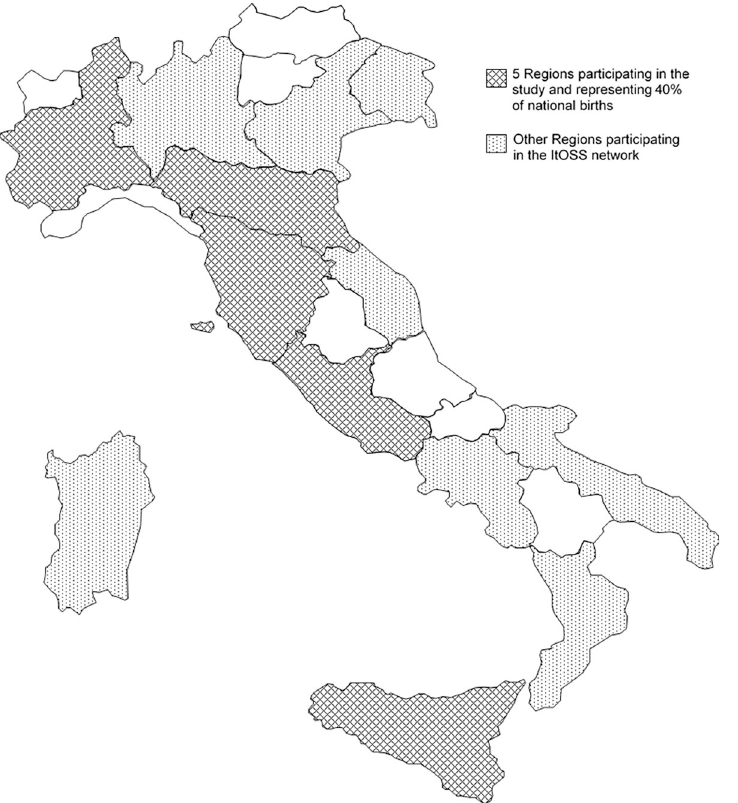
Fig 2. Italian Regions participating in the study and in the ItOSS